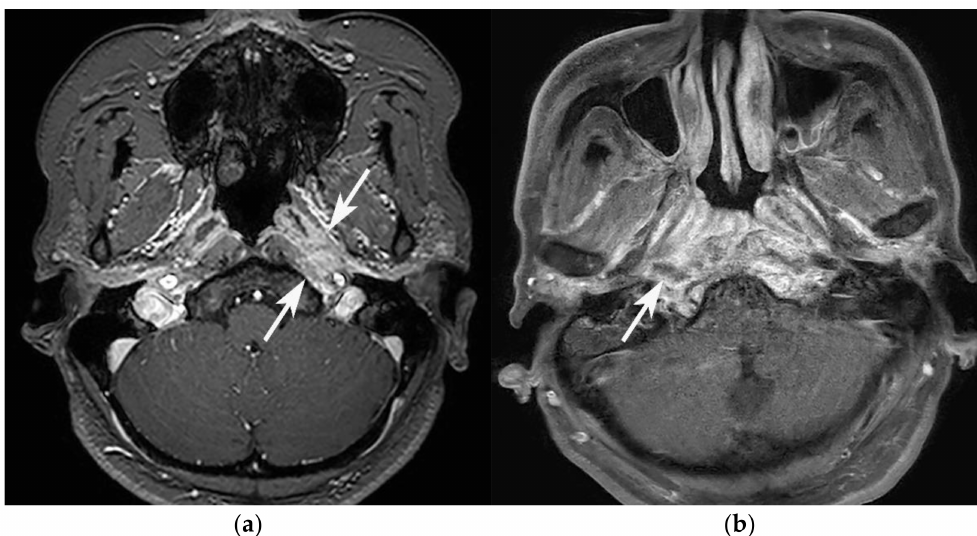
Figure 4. Comparison between GPA and SBO. ( a ) On axial contrast-enhanced T1WI of a 45-year-old female, GPA lesion shows relatively homogeneously enhancing infiltrative lesion (arrows) centered in the left side parapharyngeal space, skewed laterally from the nasopharynx. ( b ) SBO lesion of a 60-year-old male shows heterogeneously enhancing infiltrative lesion involving bilateral nasopharynx, prevertebral space, and skull base. Notably, focal internal necrosis (arrow) is seen in the right skull base